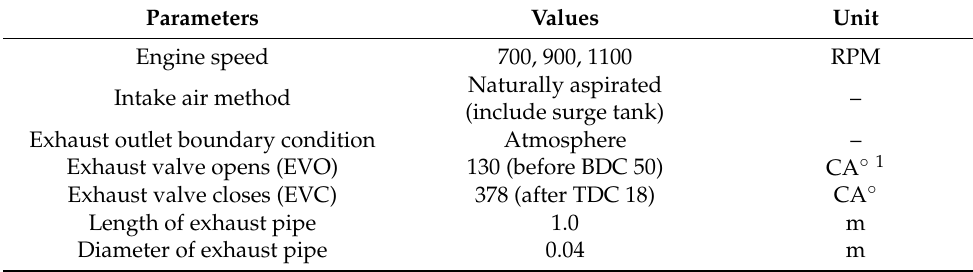
Table 1. Specifications of the experimental apparatus.